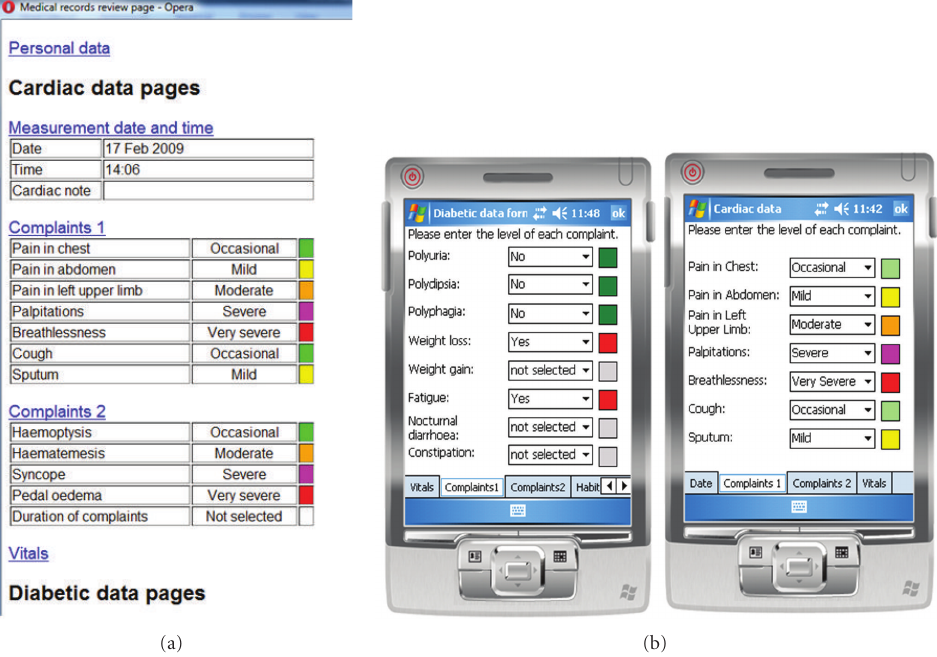
Figure 3: Example of spreadsheet data entry on browser (left) and PDA application (middle and